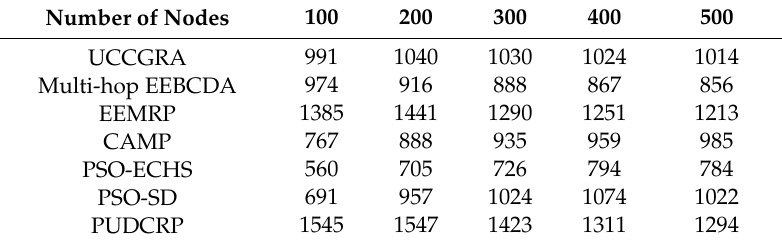
Table 4. LND of di ff erent algorithms in the 400 m × 400 m network area.